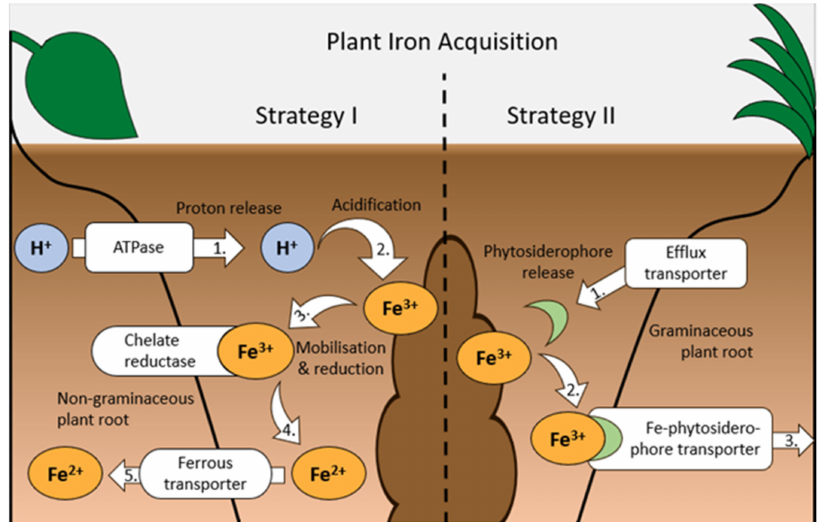
Figure 1. Diagram of the two iron (Fe) acquisition strategies employed by plants: orange ellipses show the chemical form of Fe, blue circles represent hydrogen (H + ) ions, white boxes with arrows indicate molecule transport points into/out of the root, and numbers indicate individual steps of the process (based on